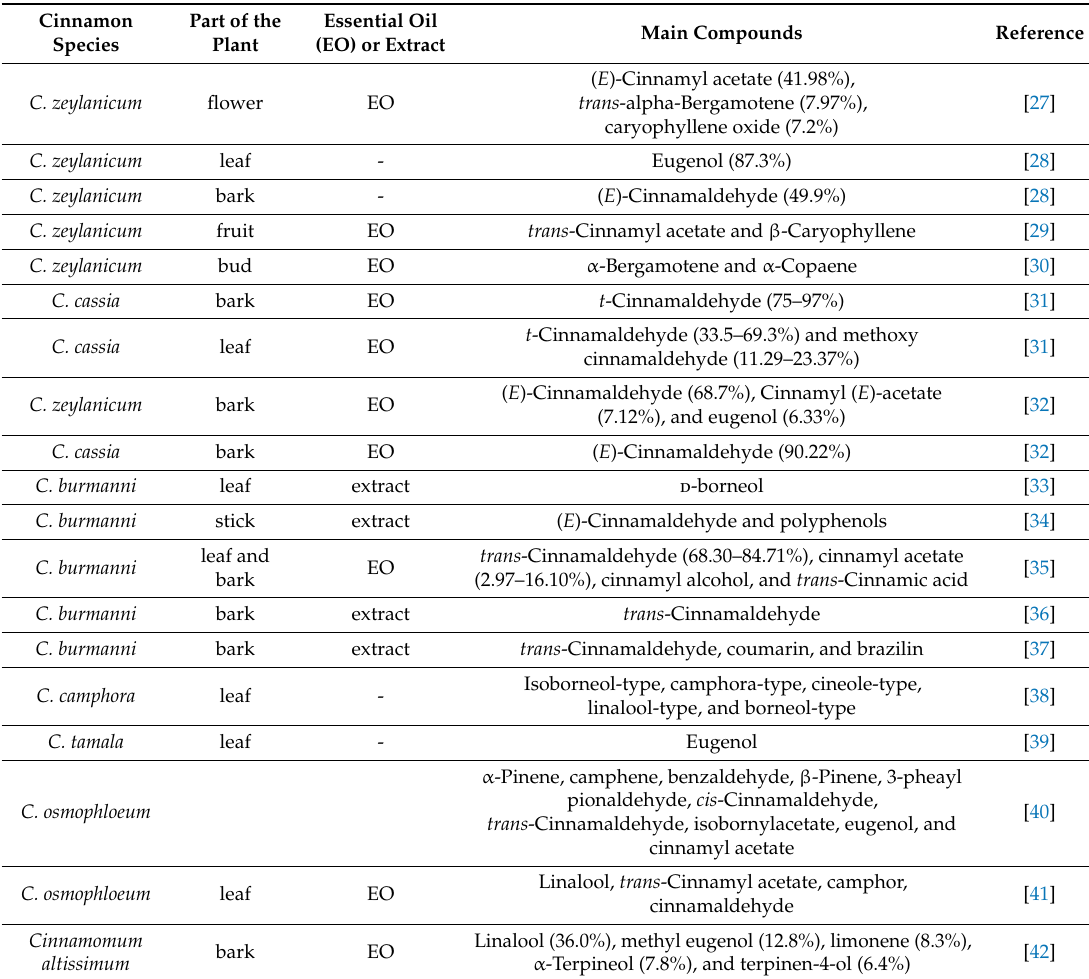
Table 1. Most abundant compounds found in di ff erent cinnamon species and parts of the